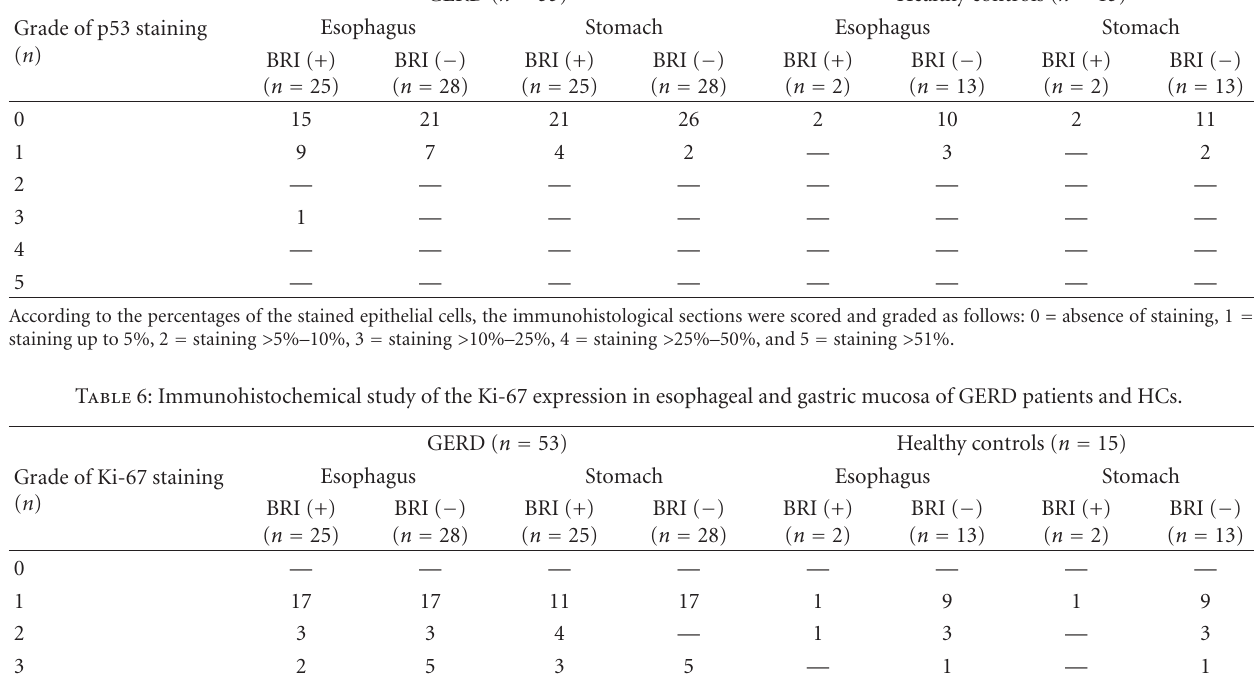
Table 5: Immunohistochemical study of the p53 expression in esophageal and gastric mucosa of GERD patients and HCs. GERD ( n = 53) Healthy controls ( n = 15) Grade of p53 staining Esophagus Stomach